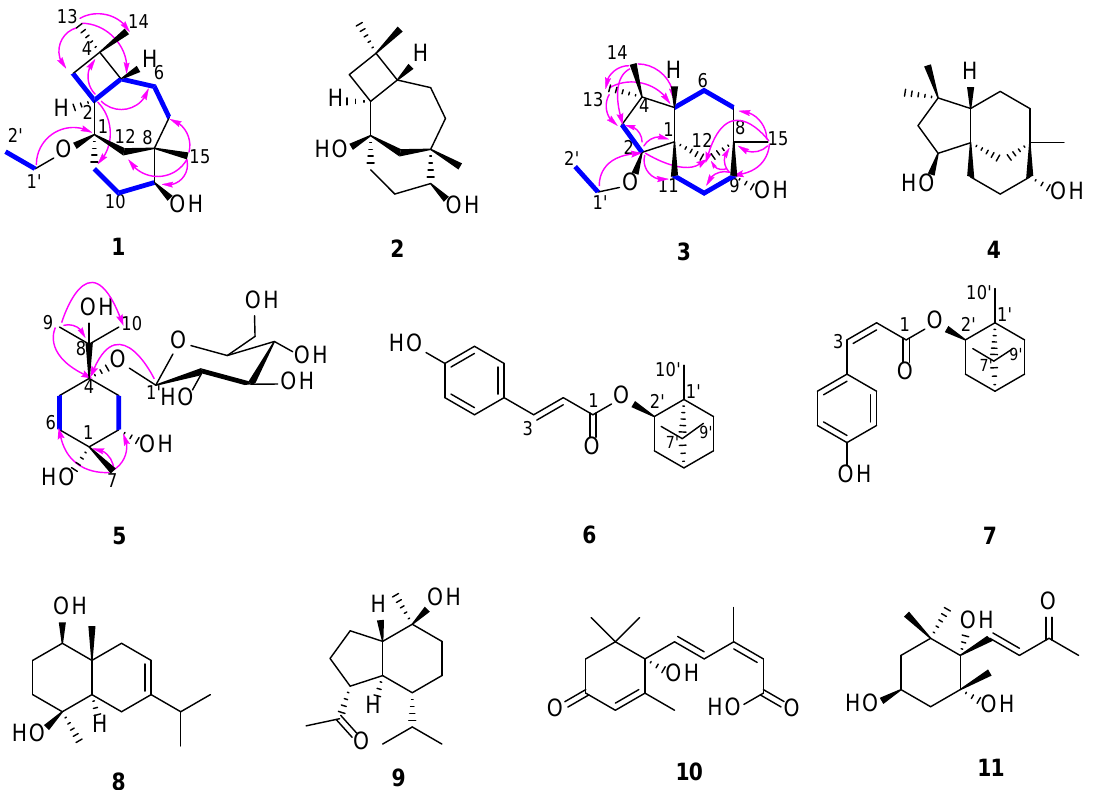
Figure 1. The structure of compounds 1 – 11 ; Selected HMBC ( → ) and 1 H- 1 H COSY ( ▬ ) correlations of 1 , 3 and 5 .